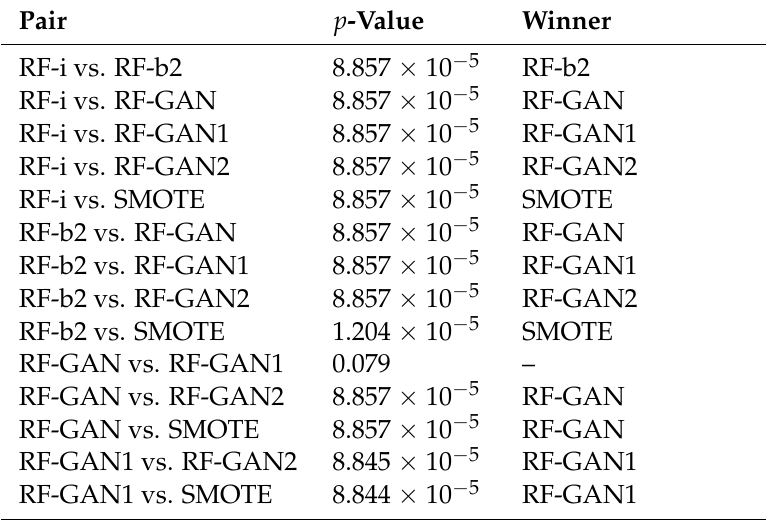
Table 3. Wilcoxon posthoc pairwise tests for the different